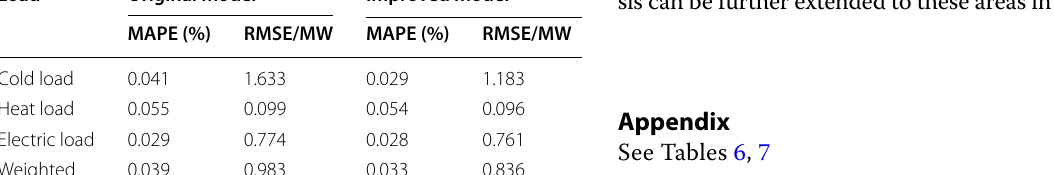
Table 5 Prediction error before and after removing the three coupled features in CF- LSTM-MTL Load Original model